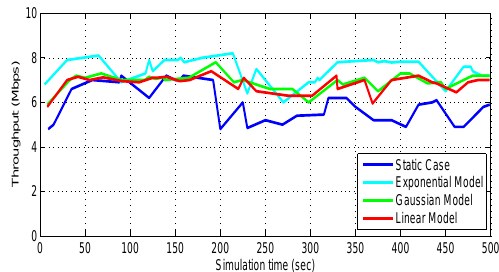
Figure 10. Throughput w.r.t. simulation time ( β = 0 . 25)